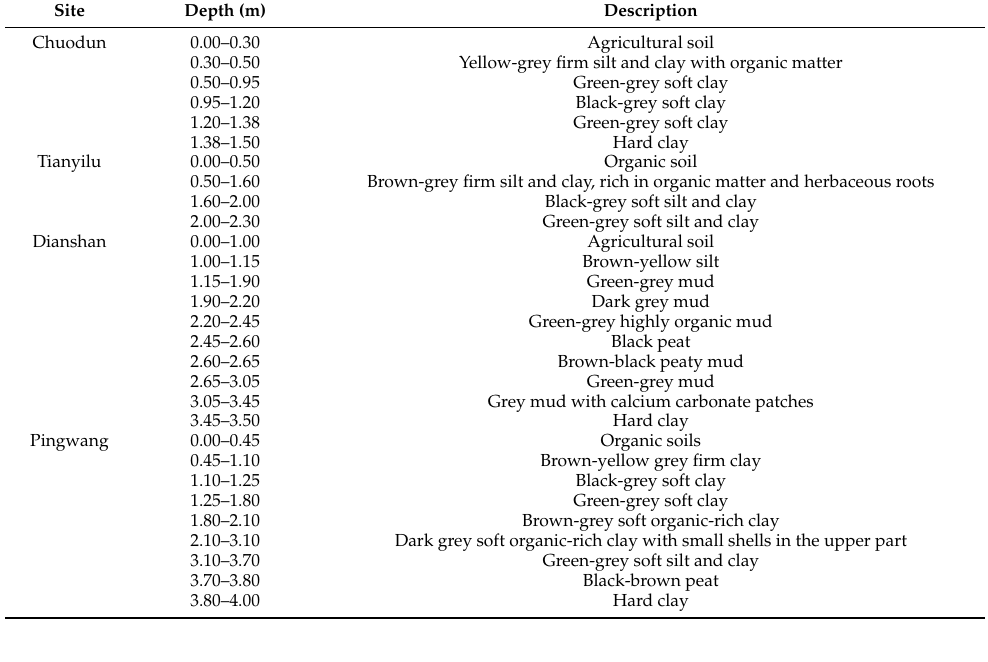
Table 1. Core lithostratigraphy for the four sites.